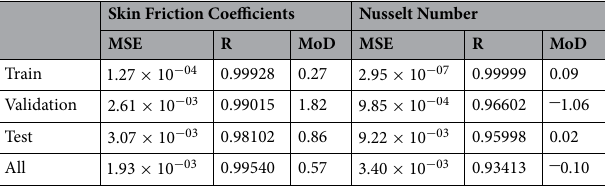
Table 2. Numerical values of performance parameters of ANN